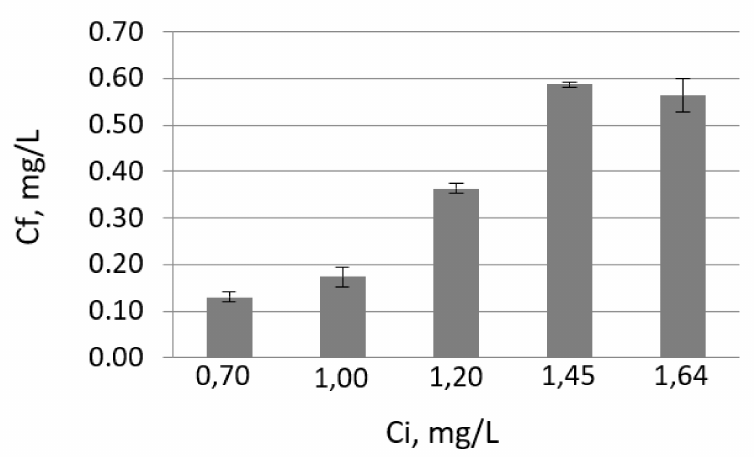
Figure 3. Error bars for experiments performed at pH